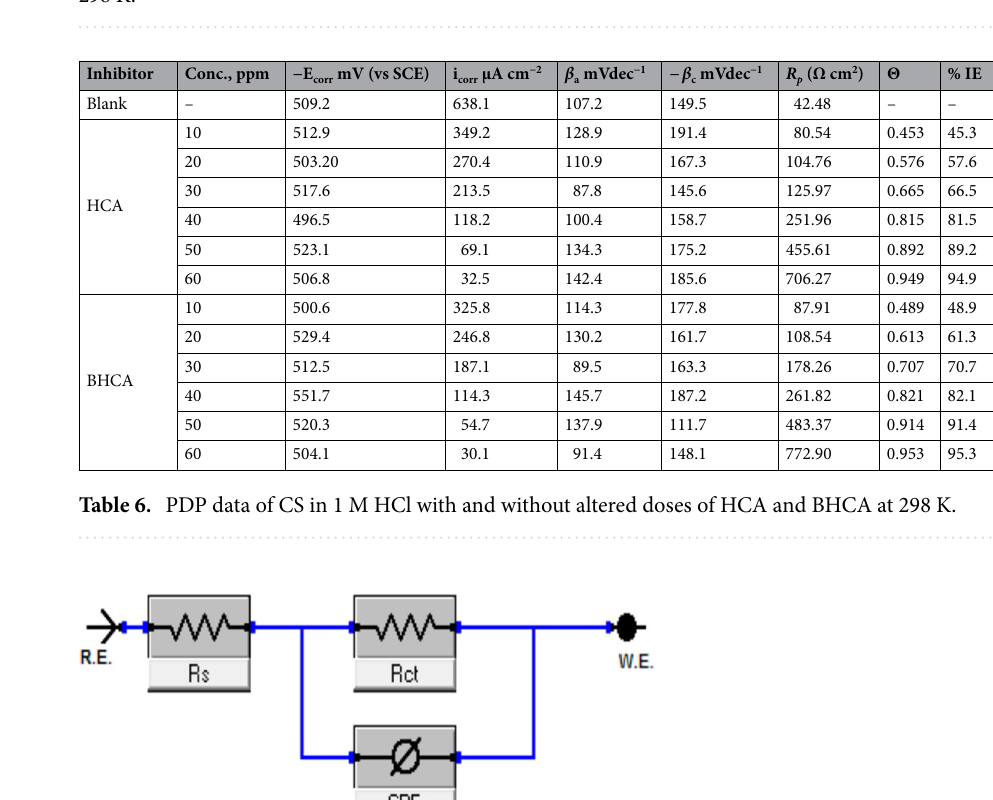
tively; illustrate Nyquist and Bode graphs in the presence and absence of various concentrations of the deriva- tives HCA and BHCA inhibitors in 1 M HCl solution. The first incomplete circle shows how the addition of these chemicals caused a delay in the rate of charge transfer, while the other half circle shows how the heterogeneity of the surface is responsible for this 64 . Comparing the Bode charts (Fig. 10) to those of the free acid, their mag- nitude increased. This could be explained by the inhibitor molecules adhering to the surface 65 . The observation that the impact is concentration-dependent suggests that at greater inhibitor concentrations, the protective layer formed by the adsorbed additives will thicken and the inhibitory effect will be enhanced. By carefully reviewing Fig. 10, it was clear that the profile of all the plots into the hostile environment, both with and without inhibitors, did not actually alter the process of CS dissolution under study. As a result of the chloride ions being dissolved by BHCA and HCA, the diameter of the haves of the circles gradually raises with increased inhibitor dosages. An